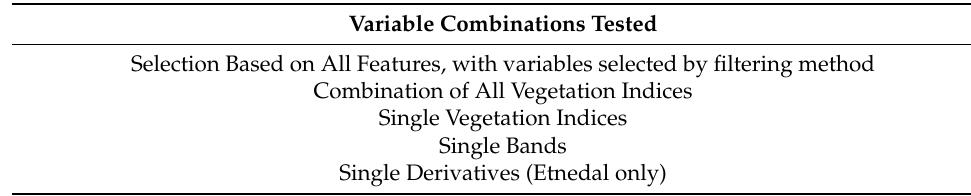
Table 3. List of the variable combinations used for SVM modeling. Variable Combinations